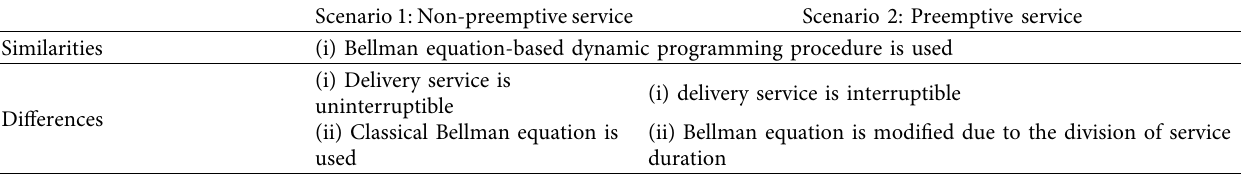
Table 4: Comparison between non-preemptive and preemptive